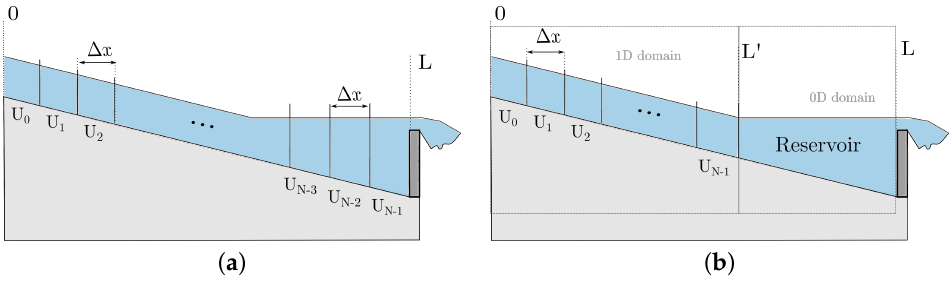
Figure 4. Representation of the two different approaches for reservoir representation: 1D distributed discretisation as the rest of the domain ( a ); or coupling the 1D model of the river with an aggregated 0D model of the reservoir ( b